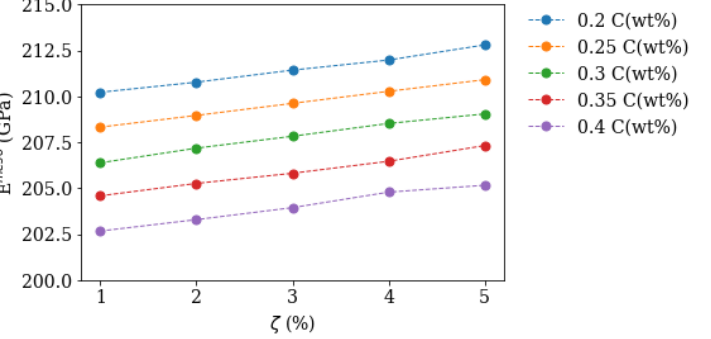
Figure 2. Calculated Young’s modulus E meso as a function of precipitate volume fraction ζ and different matrix carbon contents using the microscopic model as homogenisation function f . When the precipitate volume fraction ζ and segregation line fraction χ are